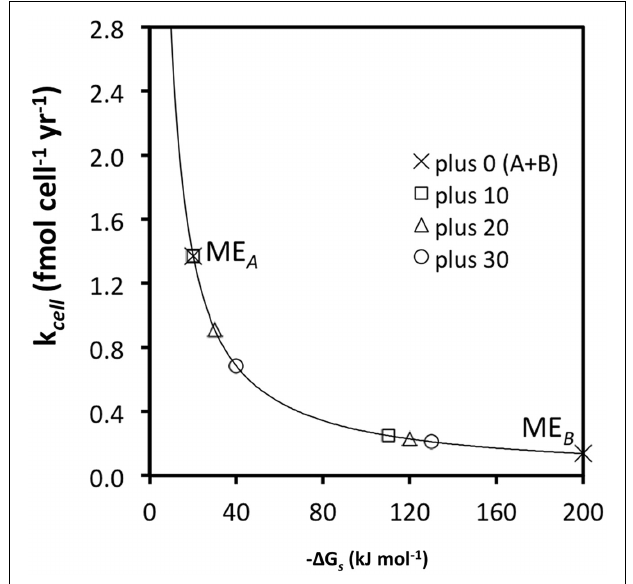
FIGURE 4 |The same relationship as in Figure 3C, except that turnover rates required for ME A and ME B (“plus 0”) are now calculated for the sum of two substrates,A and B [“plus 0 (A + B)”]. All other values are the same as